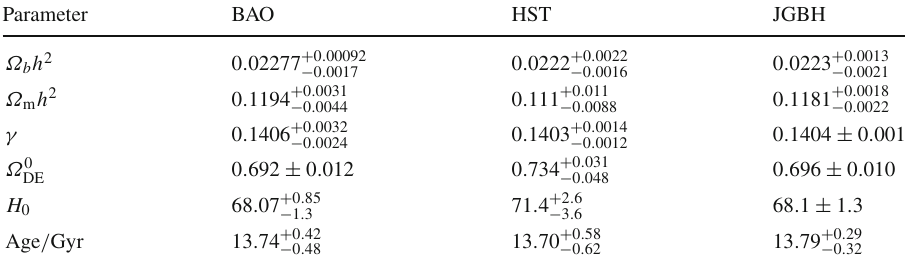
confidence limits for a model based on JLA, BAO, HST